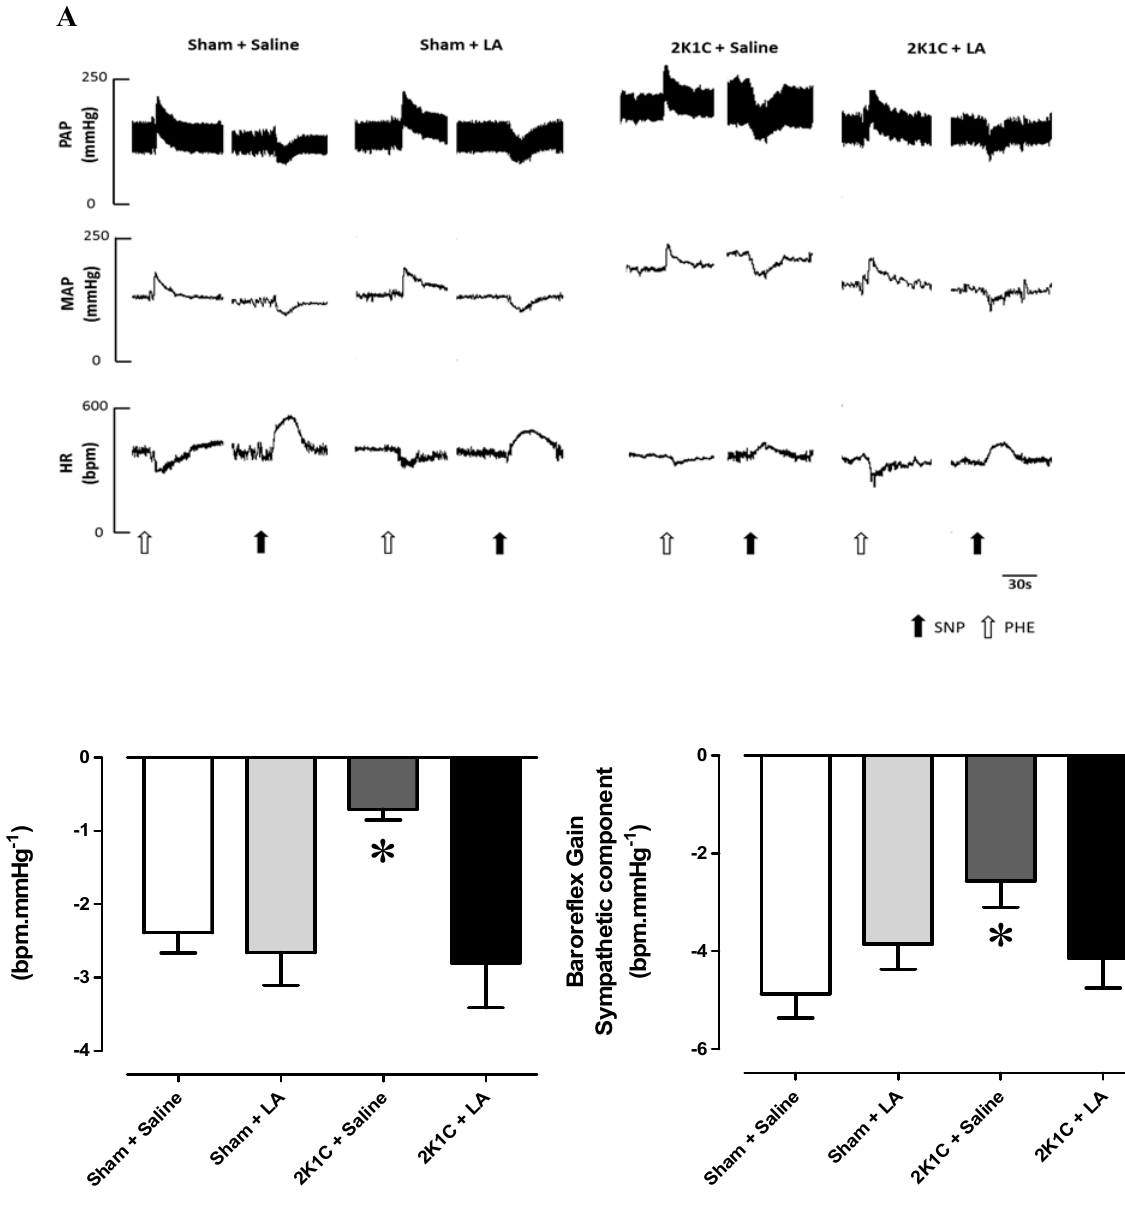
Figure 3. Baroreflex sensitivity test. ( A ) Representative tracings from each of the four groups (Sham + Saline; Sham + LA; 2K1C + Saline and 2K1C + LA) showing the changes in pulse arterial pressure (PAP, mmHg), mean arterial pressure (MAP, mmHg), and heart rate (HR, bpm) in response to phenylephrine (black arrows) and sodium nitroprusside (open arrows). ( B ) Values for baroreflex sensitivity (bpm.mmHg − 1 ) determined by the modified Oxford method using intravenous injection of NPS and Phe in Sham + Saline (n = 6, open bar); Sham + LA (n = 6, light grey bar); 2K1C + Saline (n = 6, dark grey bar) and 2K1C + LA (n = 6, black bar) groups. * p < 0.05, when compared to Sham + Saline